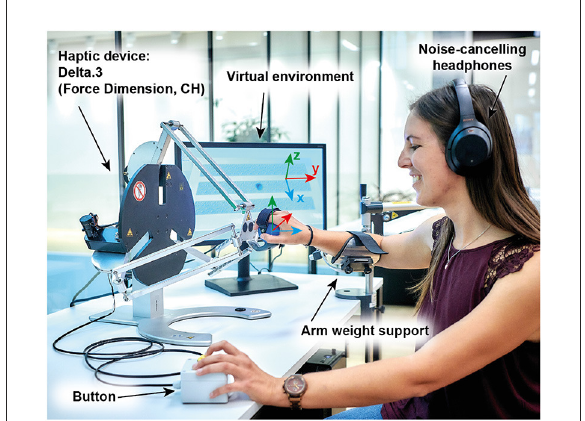
FIGURE1 Experimental set-up. The Delta.3 robot was located on a table next to a LED monitor, which showed the virtual environment. Participants wore noise-canceling headphones and used an arm-weight support system, which was adjusted to each participant’s individual arm weight. Note that the monitor is located on the right-side of a right-handed user only for illustration purposes (during the experiment it was located on the left side of the